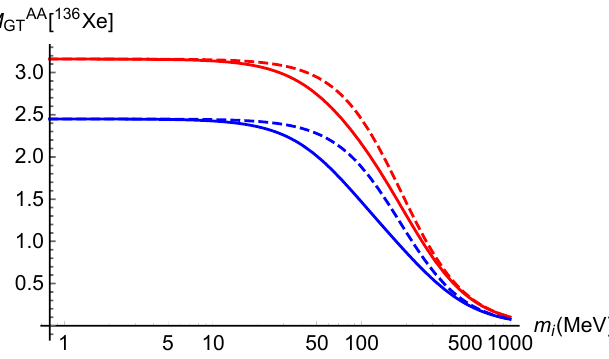
Figure 3 . The NME M AA ( m i ) for 136 Xe from the interpolation formula in eq. (6.6) (dashed) GT and eq. (6.8) (solid) using the quasi-particle random phase approximation [118] (red) and the Shell Model [119]